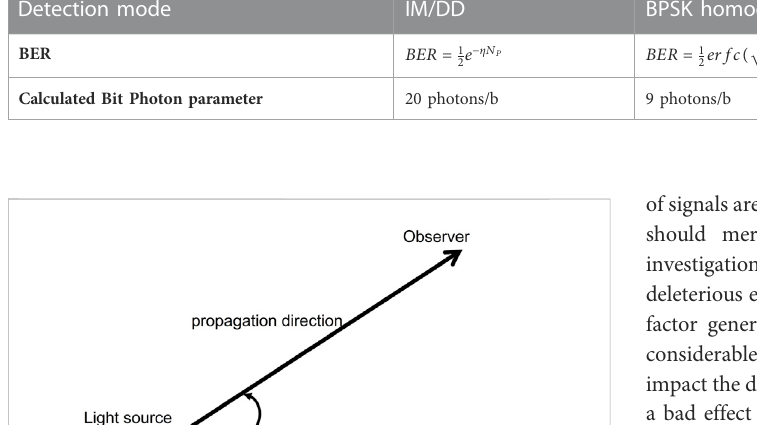
TABLE 1 Shot-noise-limited sensitivity of various types of coherent optical-communication receivers at a 1.0 × 10 − 9 bit error rate (BER). Detection mode